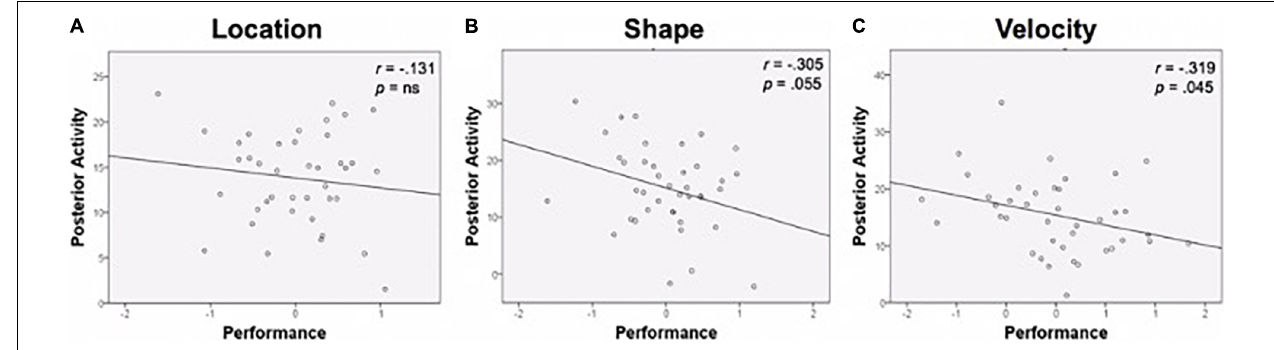
FIGURE 6 | Performance and posterior activity. (A) Location task performance and activity in the Location ROI. (B) Shape task performance was negatively related to activity in the Shape ROI. (C) Velocity task performance was negatively related to activity in the Velocity ROI. Performance is a composite z -score of response time and accuracy. ROI, region of